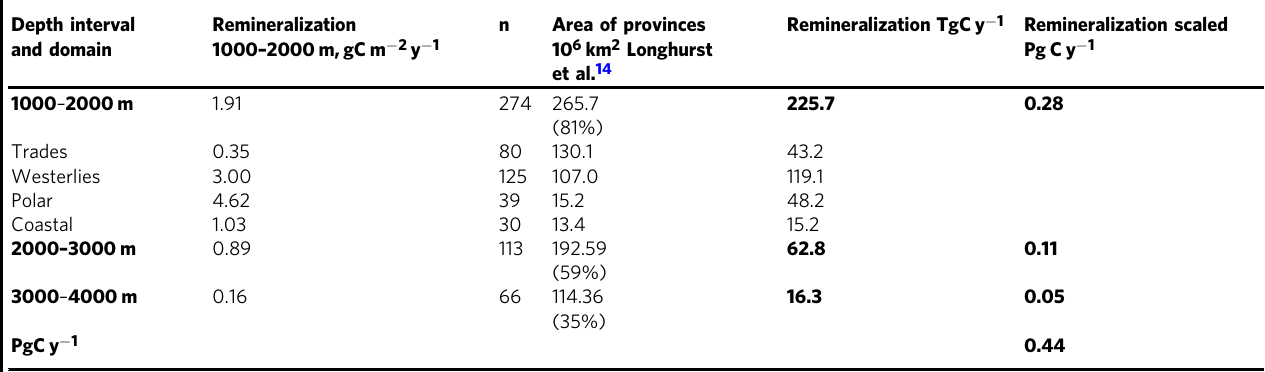
Percentage in brackets below of “ Area of provinces ” are the portions of the ocean accounted for in our review. Last column gives the total remineralization values scaled to the ocean surface given by Longhurst et al. 14 . Remineralization values for each bathypelagic layer are given in